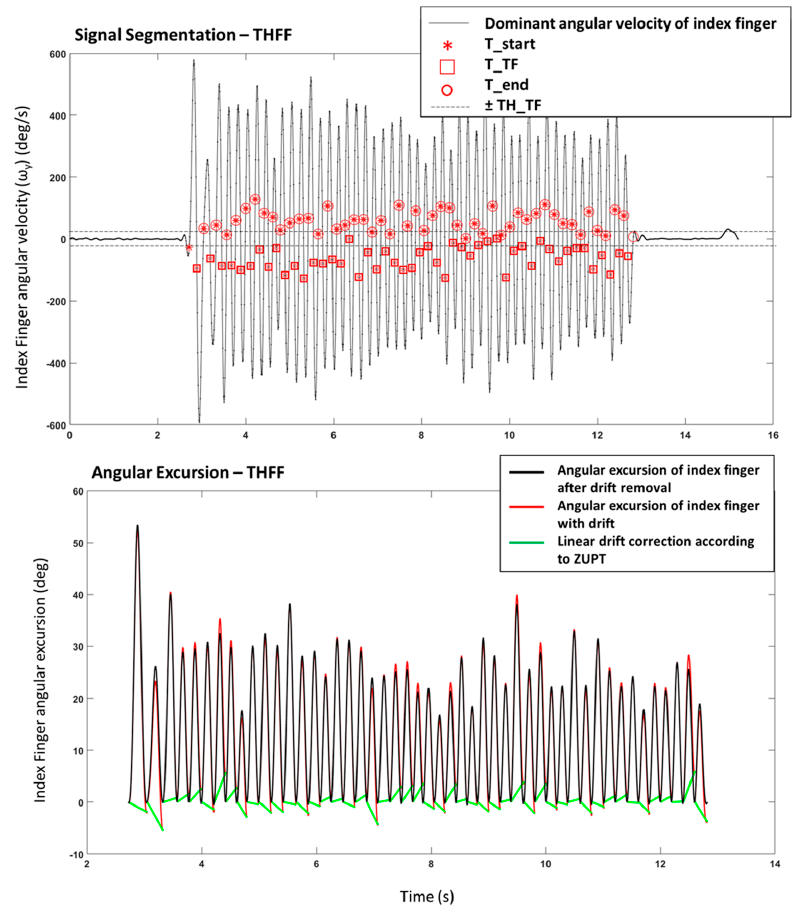
Figure 2. Example of a signal from THFF exercise. Upper panel: Signal Segmentation of the dominant angular velocity with identification of the characteristic times (T start , T TF , T end ). Lower Panel: Angular Excursion obtained from the integration of the angular velocity with and without the linear drift